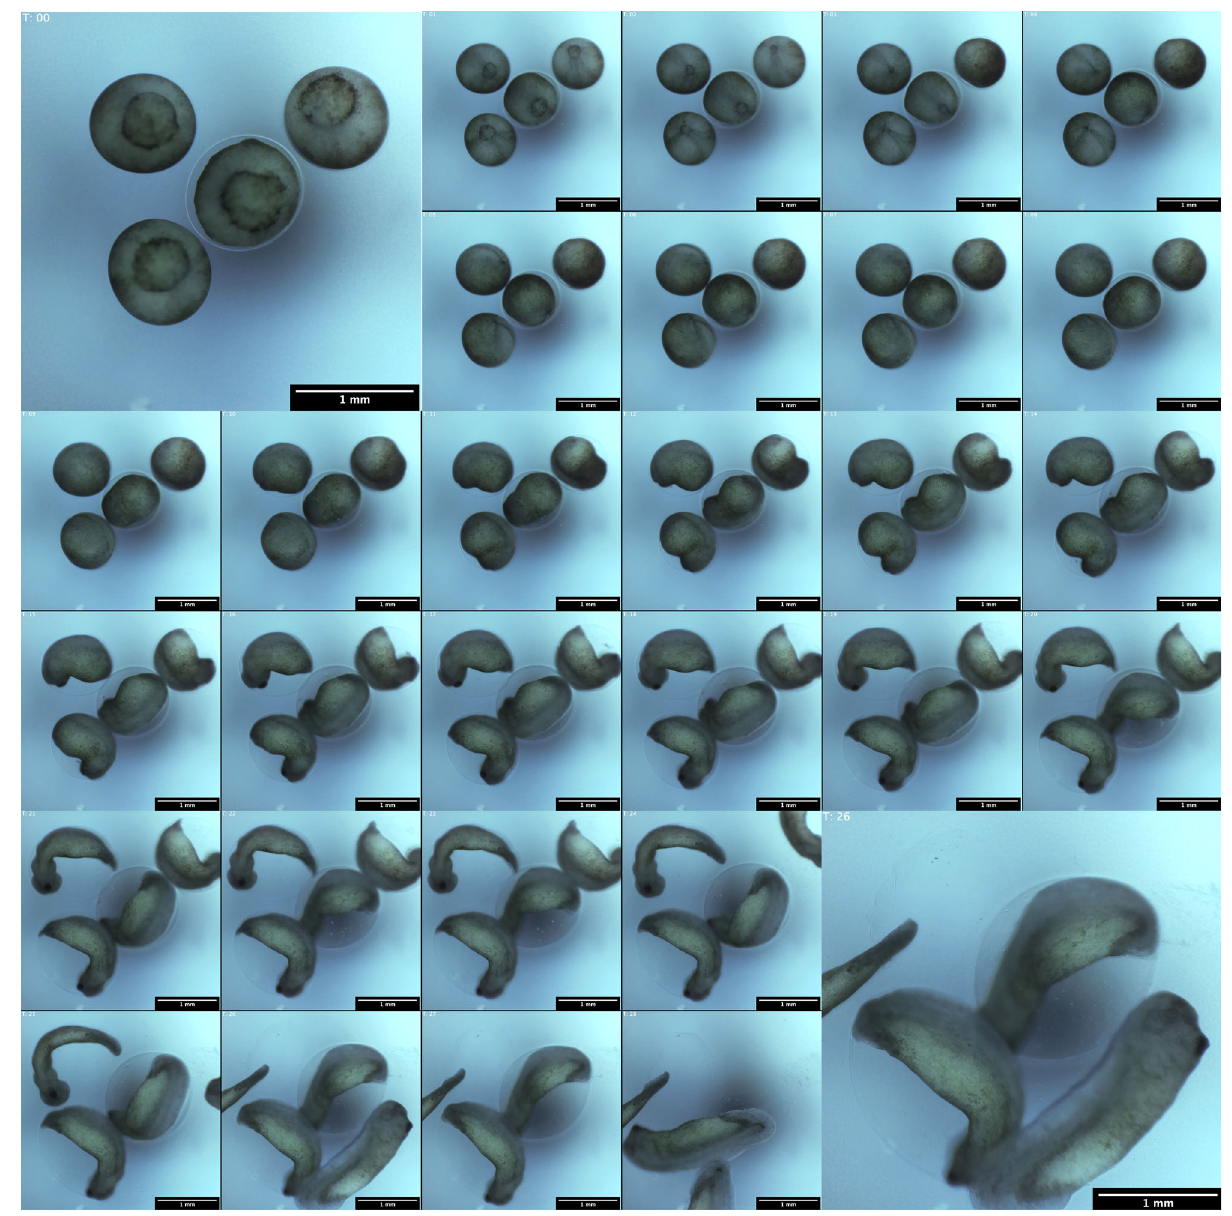
Fig. 6 Longitudinal imaging of Xenopus tropicalis development. Images of a representative well in which 4 frog embryos developed over a 28 hour period. Images were taken hourly. White Balance adjusted for